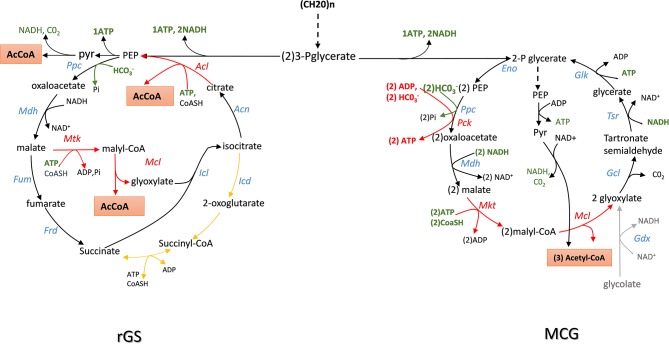
Scheme of the reversal of glyxoylate shunt (rGS) and maly-CoA Glycerate (MGC) cycling pathway for the production of acetyl-CoA from sugars with maximal carbon conservation. Enzymes abbreviation are: Ppc, PEP carboxylase; Mdh, malate dehydrogenase; Fum, fumarase; Frd, fumarate reductase; AceA, isocitrate lyase; Aco, aconitase; Acl, acyl-CoA lyase: Mtk, malate thiokinase; Mcl, malyl-CoA lyase; Gdh, glycolate dehydrogenase; Gcl, glyoxylate carboxyligase; Tsr, tartronate semialdehyde reductase; Glk, glycerate kinase; Eno, enolase.